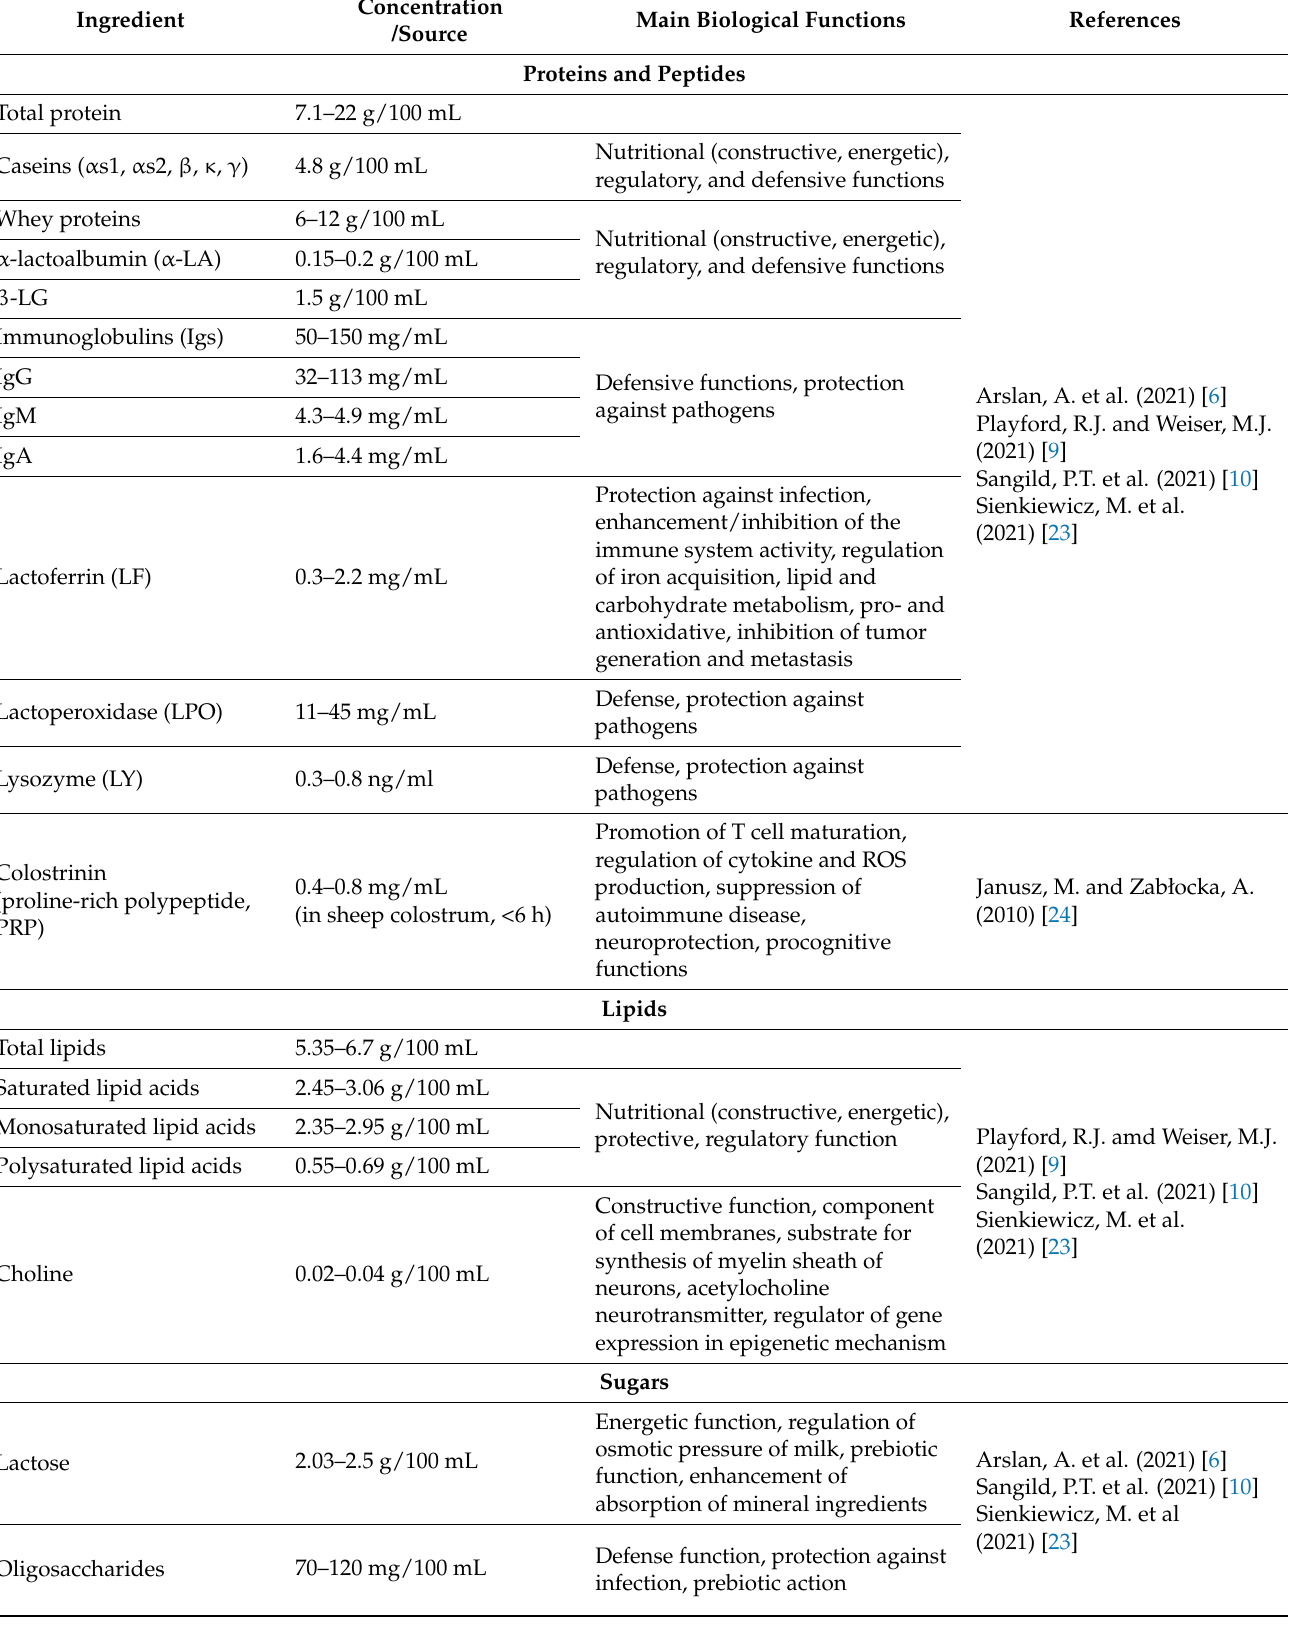
Table 1. The composition of bovine